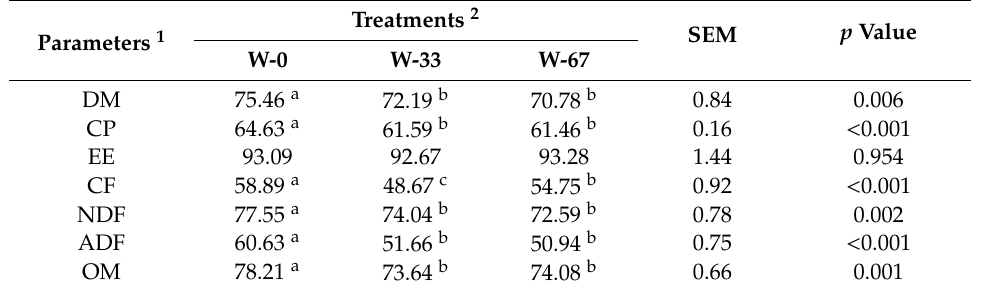
Table 4. Apparent digestibility (%) of nutrients in water-restricted male Najdi lambs fed a pelleted diet. Parameters